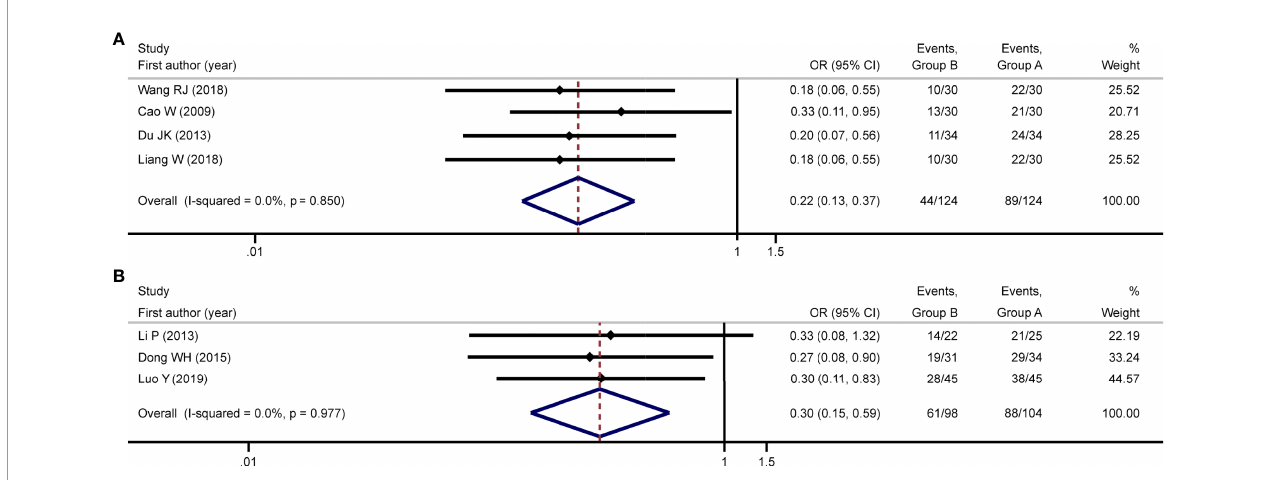
FIGURE 3 | Meta-analysis of tumor response. Meta-analysis of tumor response was conducted using studies with WHO criterion and RECIST criterion, respectively. Using studies reporting tumor response with WHO criterion, the meta-analysis found group A was associated with improved overall response rate compared to group B [OR: 0.22; 95% CI: 0.13-0.37; (A) ]. Using studies reporting tumor response with RECIST criterion, the meta-analysis found group A was associated with improved overall response rate compared to group B [OR: 0.30; 95% CI: 0.15-0.59; (B) ]. No heterogeneity was detected in either meta-analysis. Group A: TACE in